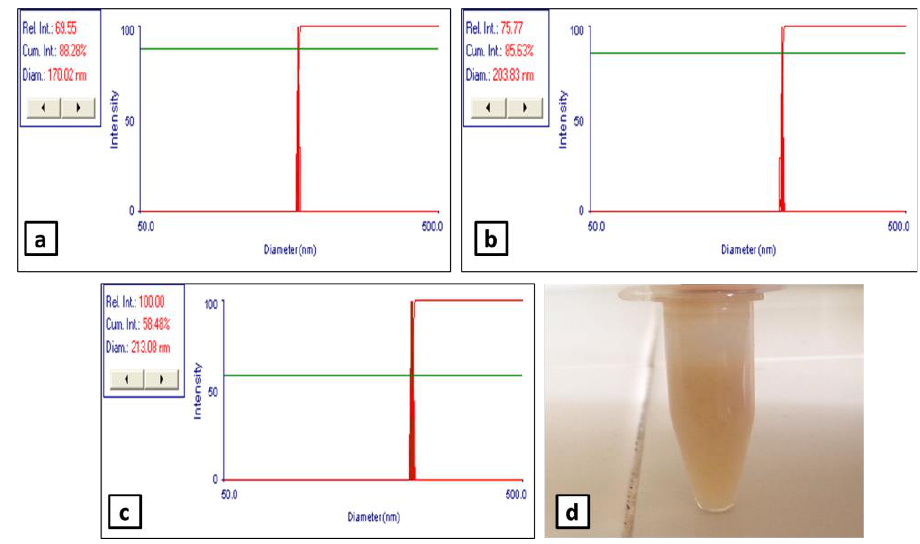
Figure 1. ( a ) Particle size of blank formulation, ( b ) SSD-loaded formulation, and ( c ) SSD-loaded nanolotion; and ( d ) appearance of SSD-nanolotion. The red peak is basically presenting the size.